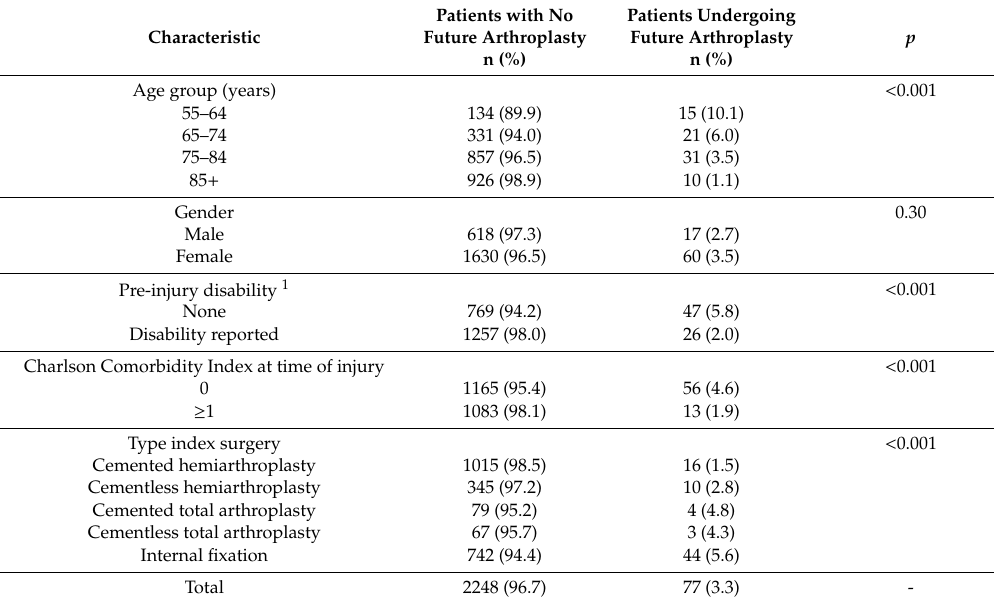
Table 1. Characteristics of included patients (n = 2325) and factors associated with future revision arthroplasty / conversion to